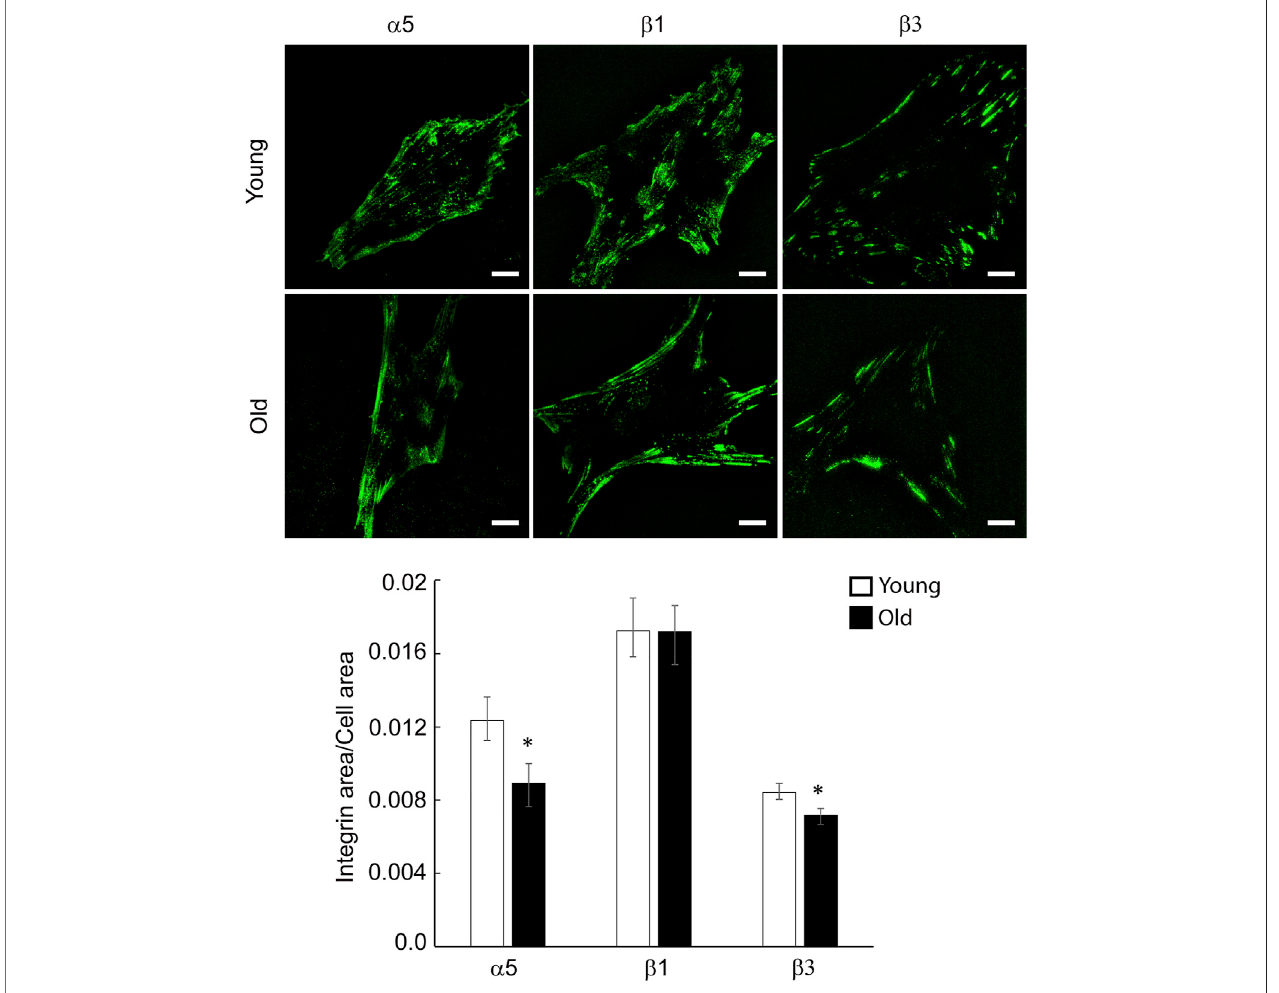
FIGURE3| RepresentativeTIRFimagesofVSMcellsisolatedfromyoungandoldFischer344rats fl uorescentlylabeledforintegrin α 5, β 1and β 3areshown.Scale bar represents 10 μ m. Quantitative measurements ( n = 29 – 39) are presented as mean ± SE. *Signi fi cance was evaluated at p < 0.05.